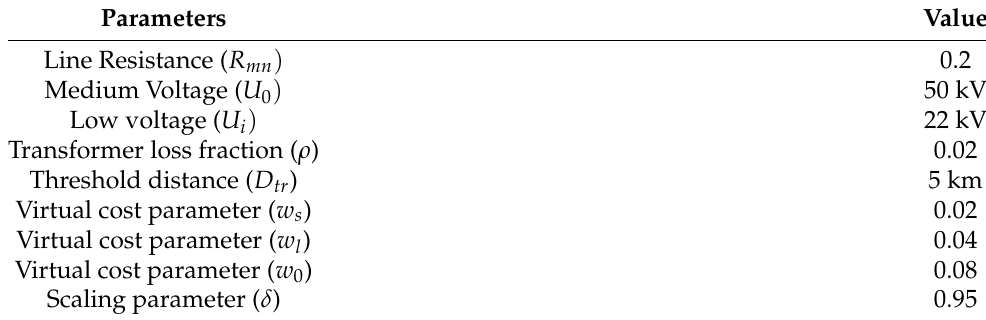
Table 2. Summary of simulation